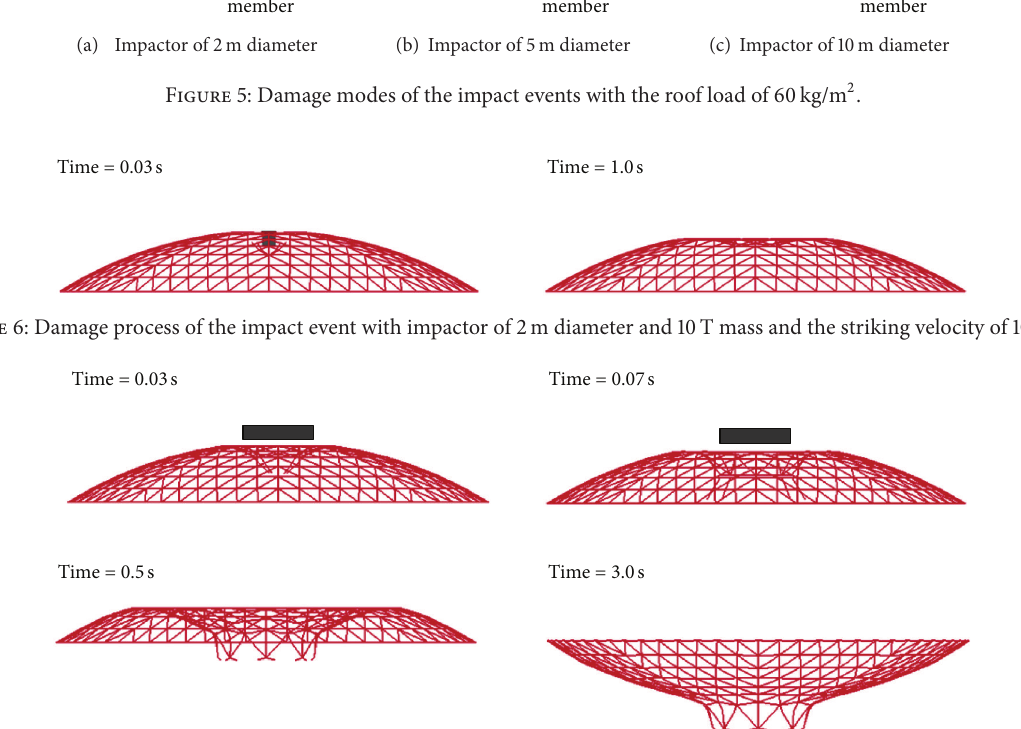
10 m is in the range of Mode 3. Thus, it is indicated that the change of the impactor size with the same initial striking kinetic energy can lead to the variation of the damage